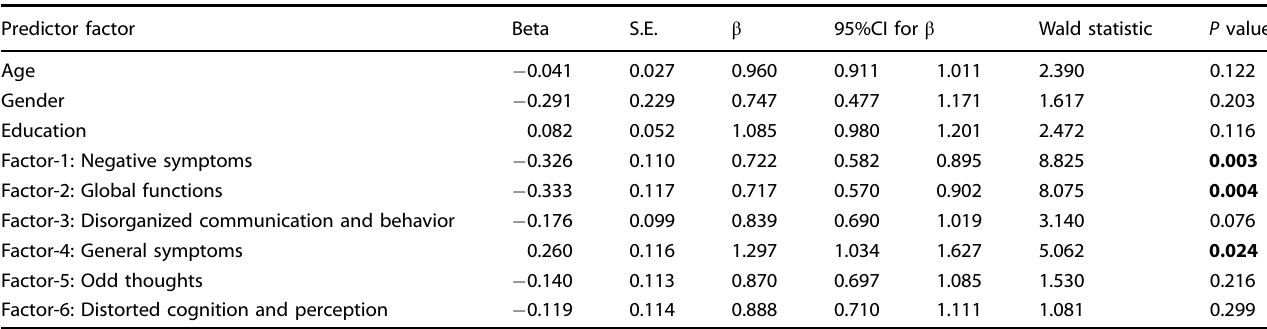
Table 5. Logistic regression for predicting the conversion to psychosis on demographic and factorial variables ( n =